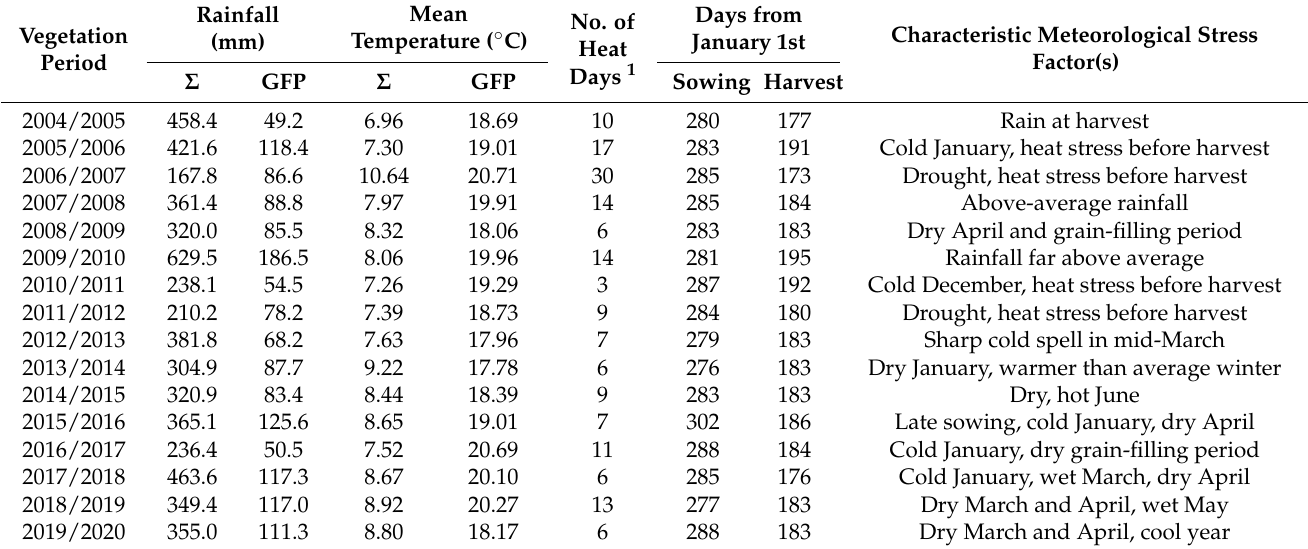
Table 7. Meteorological characteristics of the vegetation periods between 2004/2005 and 2019/2020 (Martonv á s á r,